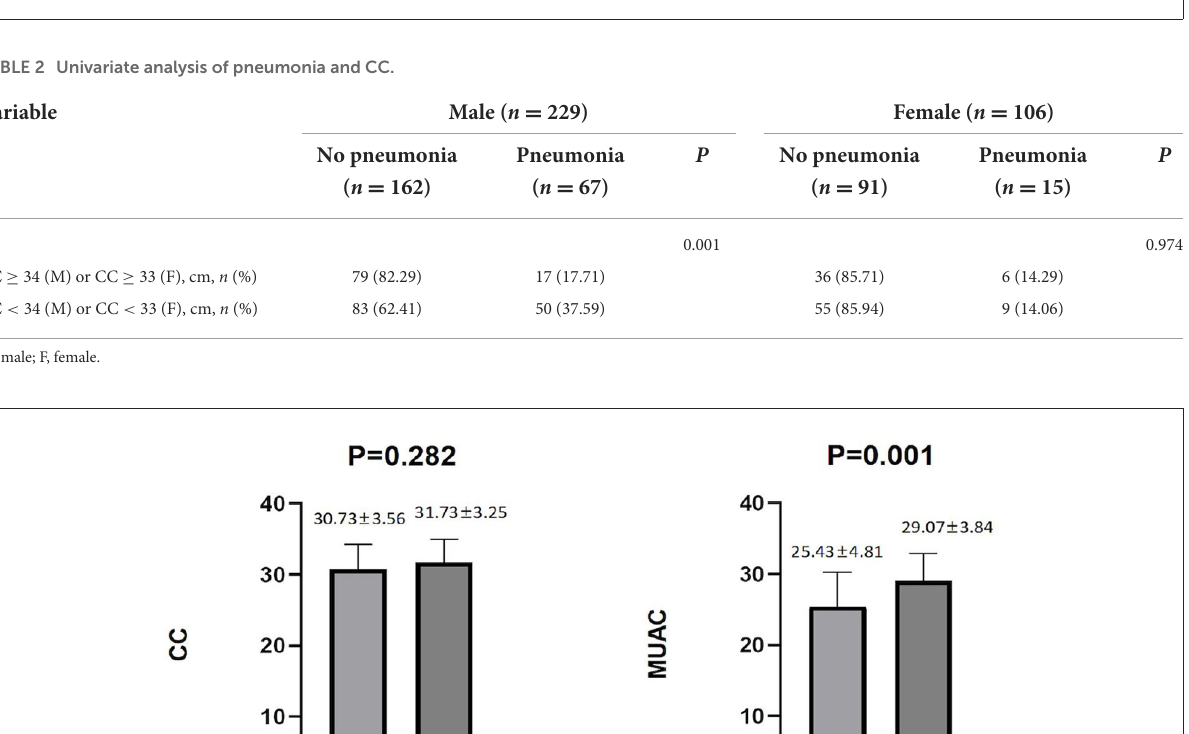
FIGURE2 Differences in CC and MUAC between pneumonia and non-pneumonia in males. The Student’s t- test was employed for comparison of two groups.